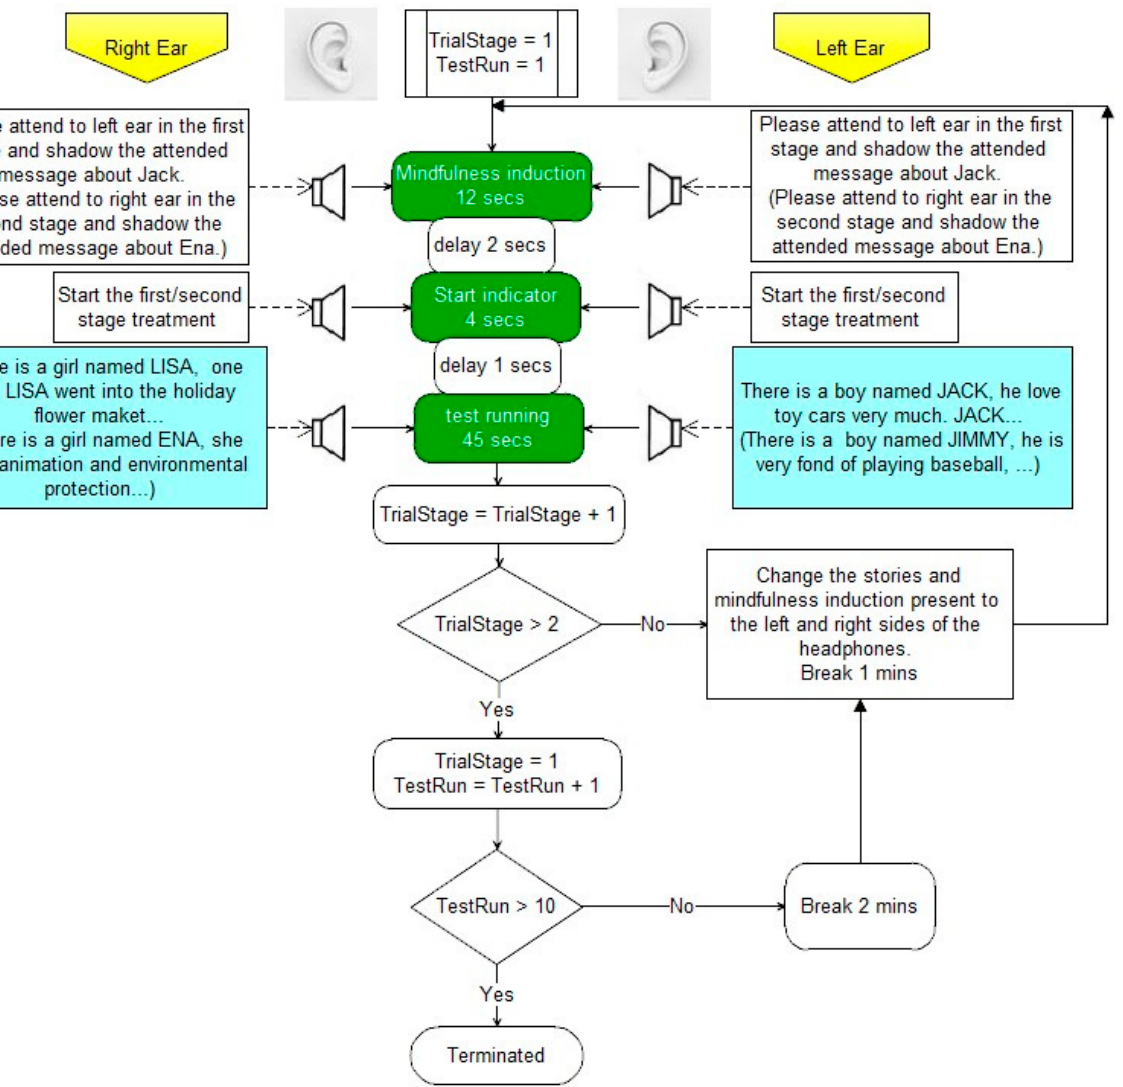
Figure 6. The flowchart of the test procedure. The audio stories in blue squares were played in Chinese by the system during the operation.